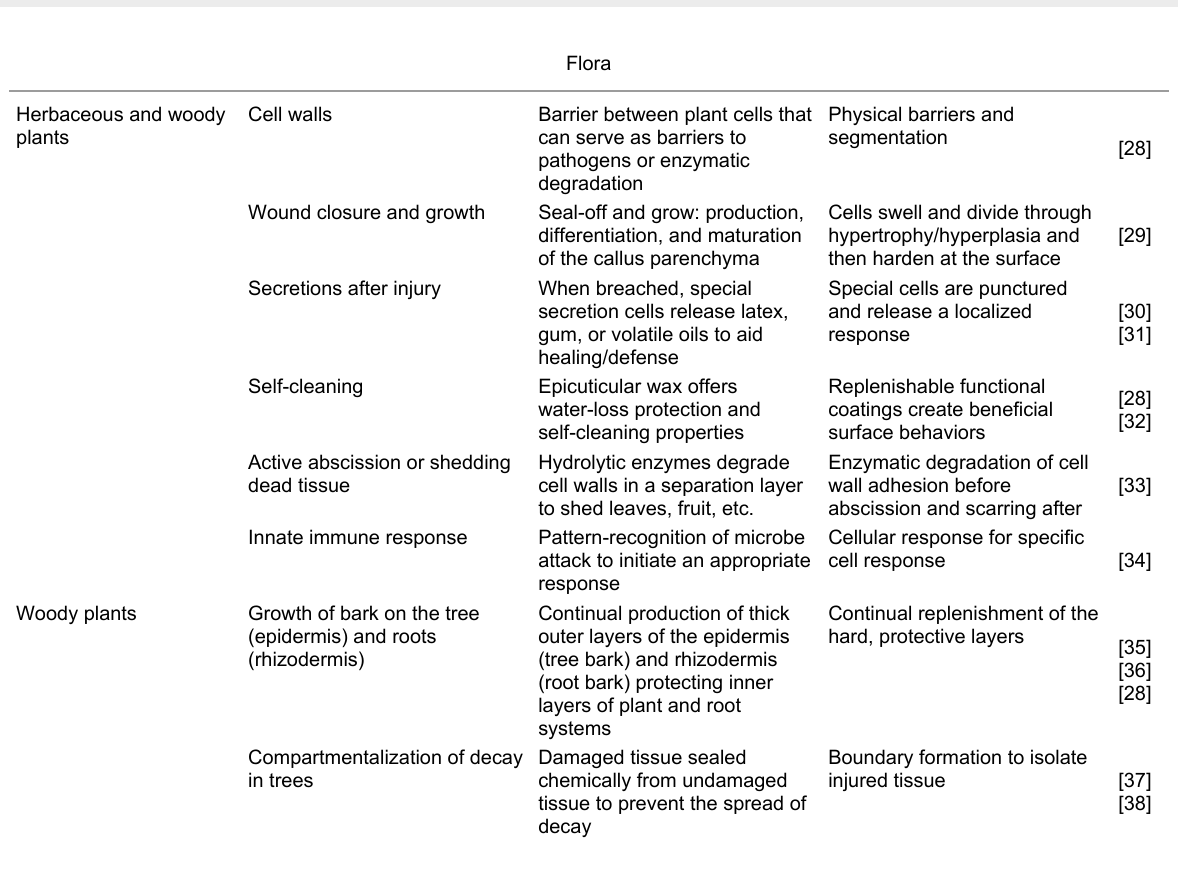
Table 1: Self-healing and defense mechanisms found in living nature. (continued)